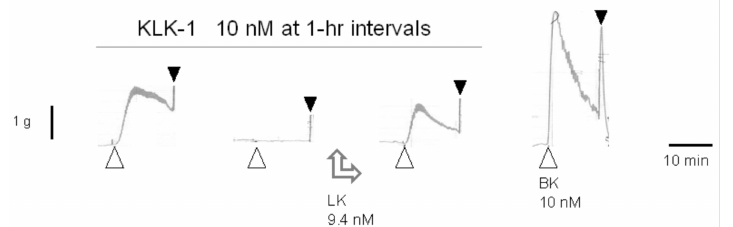
Figure 4. Effect of low-molecular-weight kininogen (LK) replenishment (9.4 nM applied between the second and third stimulation) on tissue kallikrein (KLK-1)-induced contraction in the isolated human umbilical vein. LK restored the effect of the protease in desensitized tissues. Presentation as in Figure 1B. Modified from [81] with